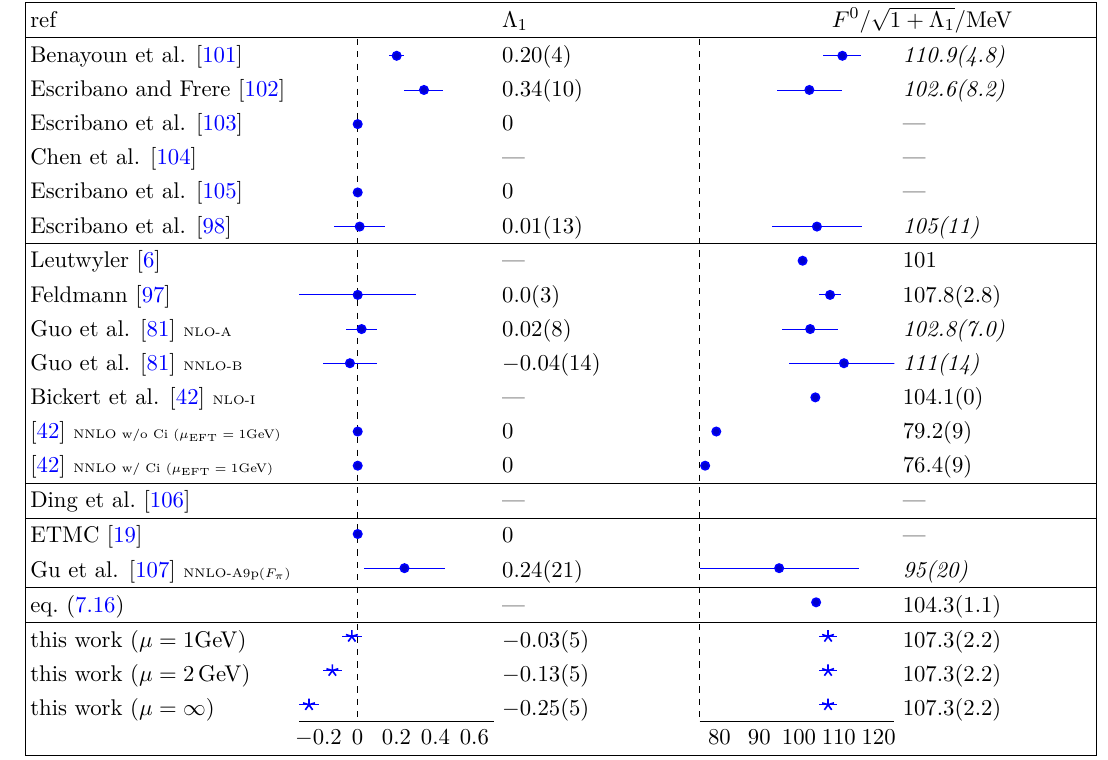
Table 18. Comparison of determinations of the (scale dependent) large- N c ChPT LEC Λ 1 and the scale independent combination of Λ 1 and F 0 , where eq. (7.16) refers to the NLO result from literature pion and kaon decay constants. The values indicated in Italics have been computed by us from F 0 and Λ 1 with naive error propagation. The results from this work are presented at three different